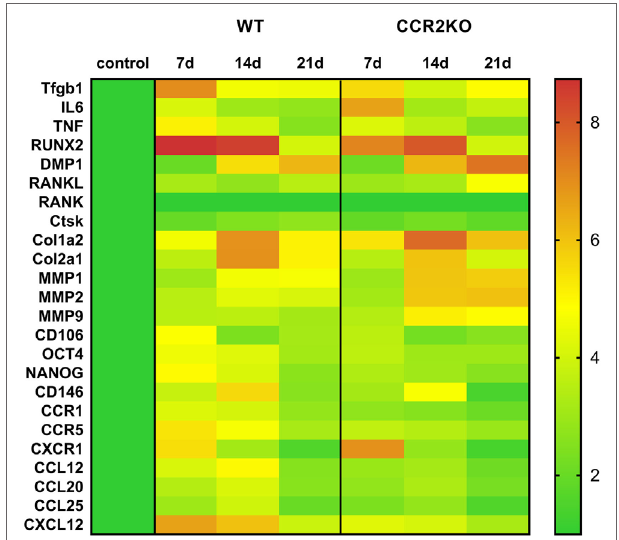
FigUre 6 | Kinetics of gene expression in the intramembranous bone healing after tooth extraction in wild-type (WT) vs CCR2KO mice. RealTime PCR array pooled from of all the experimental time periods for each strain (WT and CCR2KO mice) was used to identify targets with a significant expression variation for their subsequent analyses in different time points along bone healing post tooth extraction (7, 14, and 21 days). RealTime PCR array analysis was performed with the VIA7 system (Applied Biosystems, Warrington, UK) using a customized qPCR array comprised of the major targets from the Osteogenesis, Inflammatory Cytokines & Receptors, and Wound Healing panels of the PCR array RT 2 Profiler (SABiosciences/QIAGEN). Results are depicted as the fold increase change (and the SD) in mRNA expression from triplicate measurements in relation to the control samples and normalized by internal housekeeping genes (GAPDH, HPRT, and β